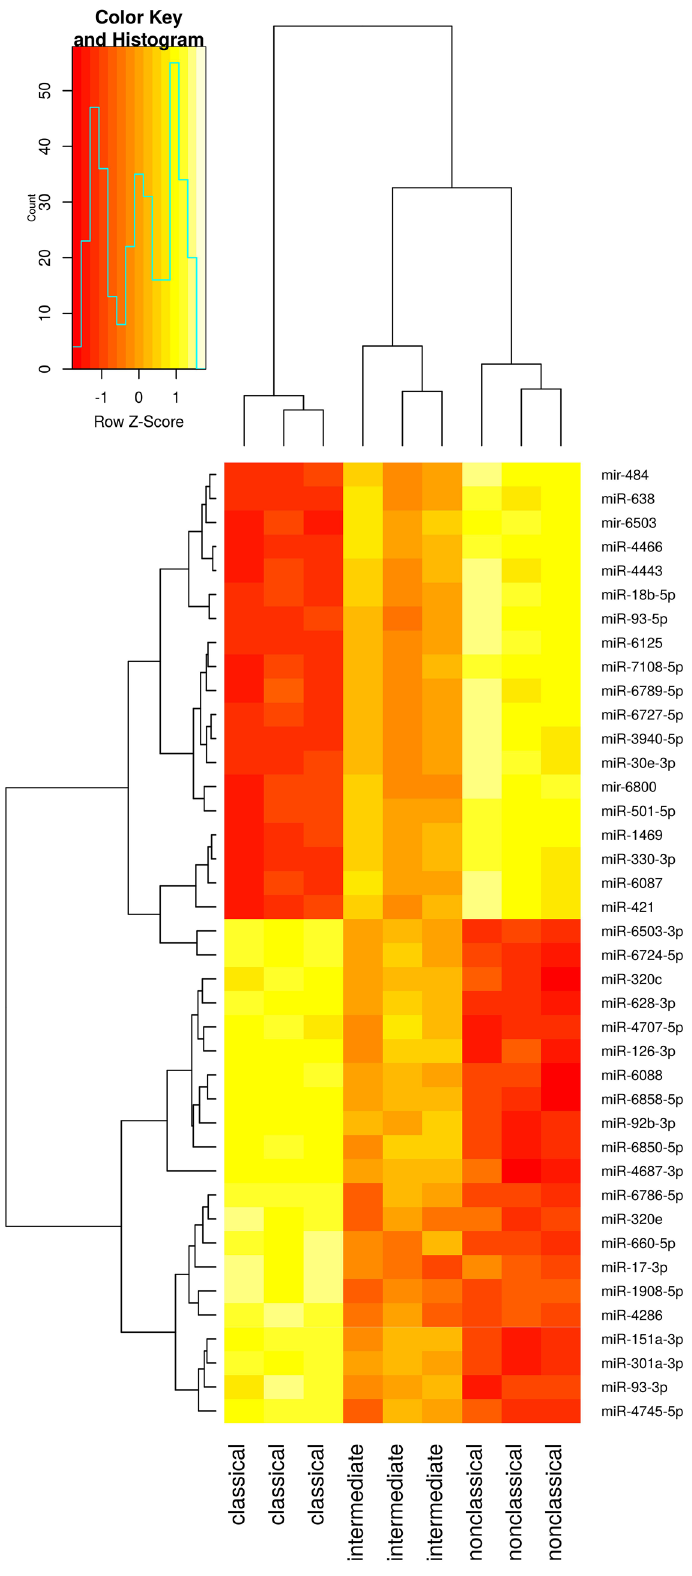
Figure 3. Heat map presentation based on hierarchical clustering of the top significantly expressed miRNAs between classical and nonclassical monocytes in control samples. The values for the particular miRNAs for the intermediate monocyte subset represent the transitional character of this